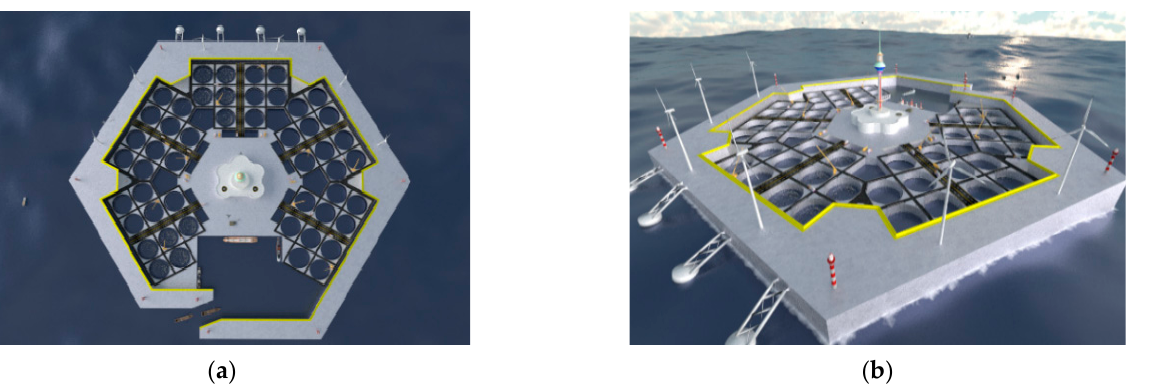
Figure 1. HEXAGON: a mega offshore floating fish farm: ( a ) plan view; ( b ) isometric view. Garrett [8] determined the wave motion inside a thin ‐ walled bottomless harbour us ‐ ing an analytical method. Mavrakos [11] and Mavrakos [12] extended Garrett [8] study